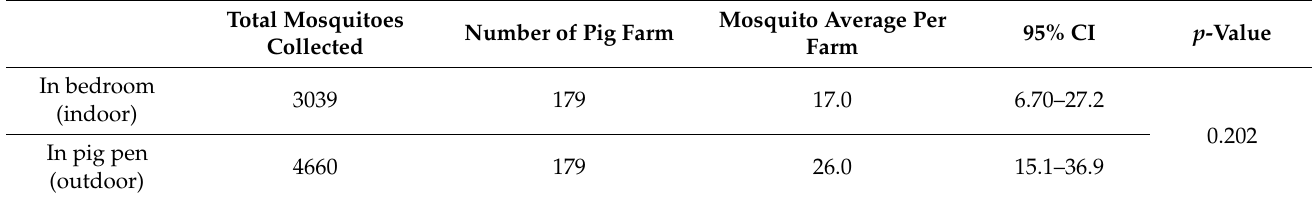
Table 8. Comparison of mosquitoes collected between pig owner bedroom and pig